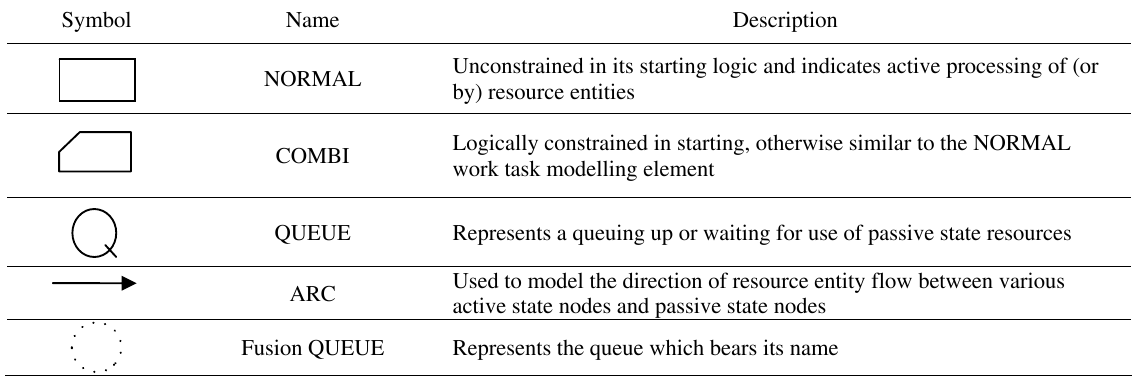
Table 1 . STROBOSCOPE simulation elements [10]